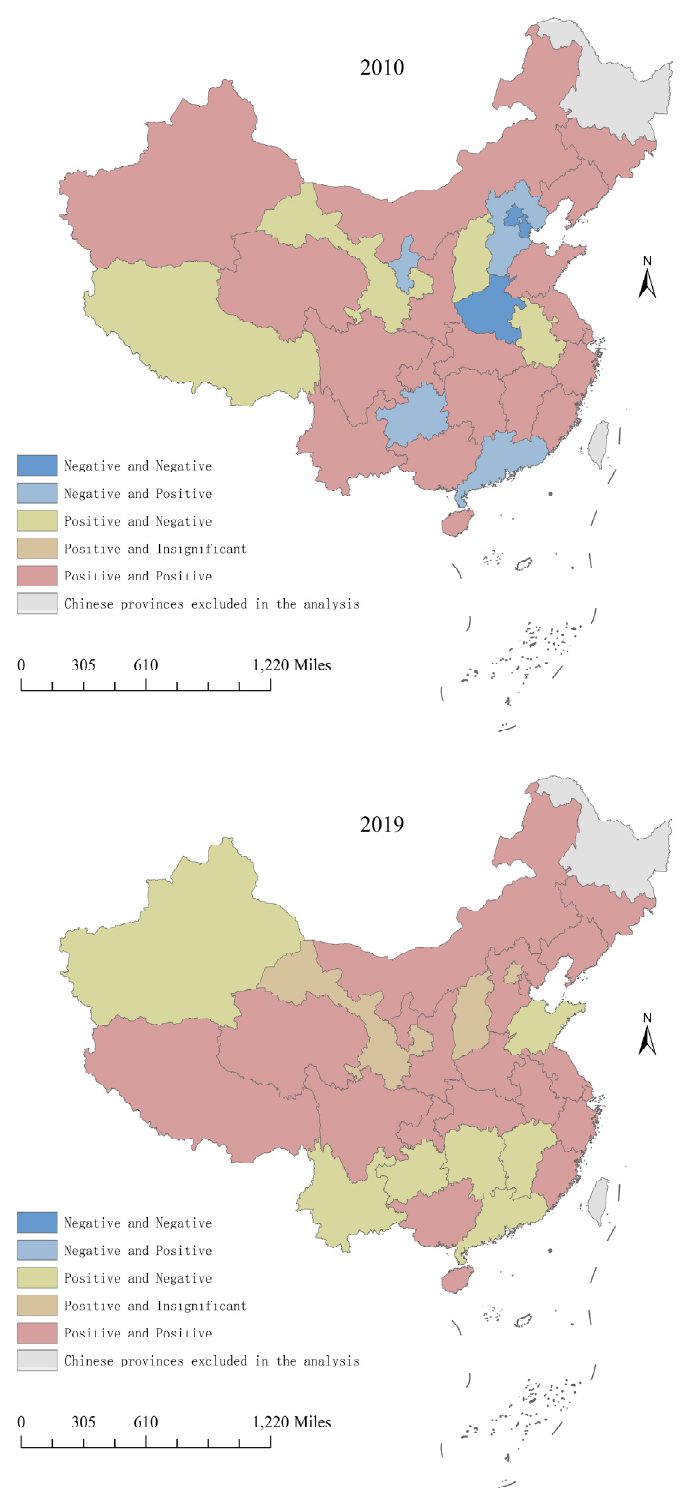
Figure 2. Spatial distribution of the combined impact of HSR and aviation.